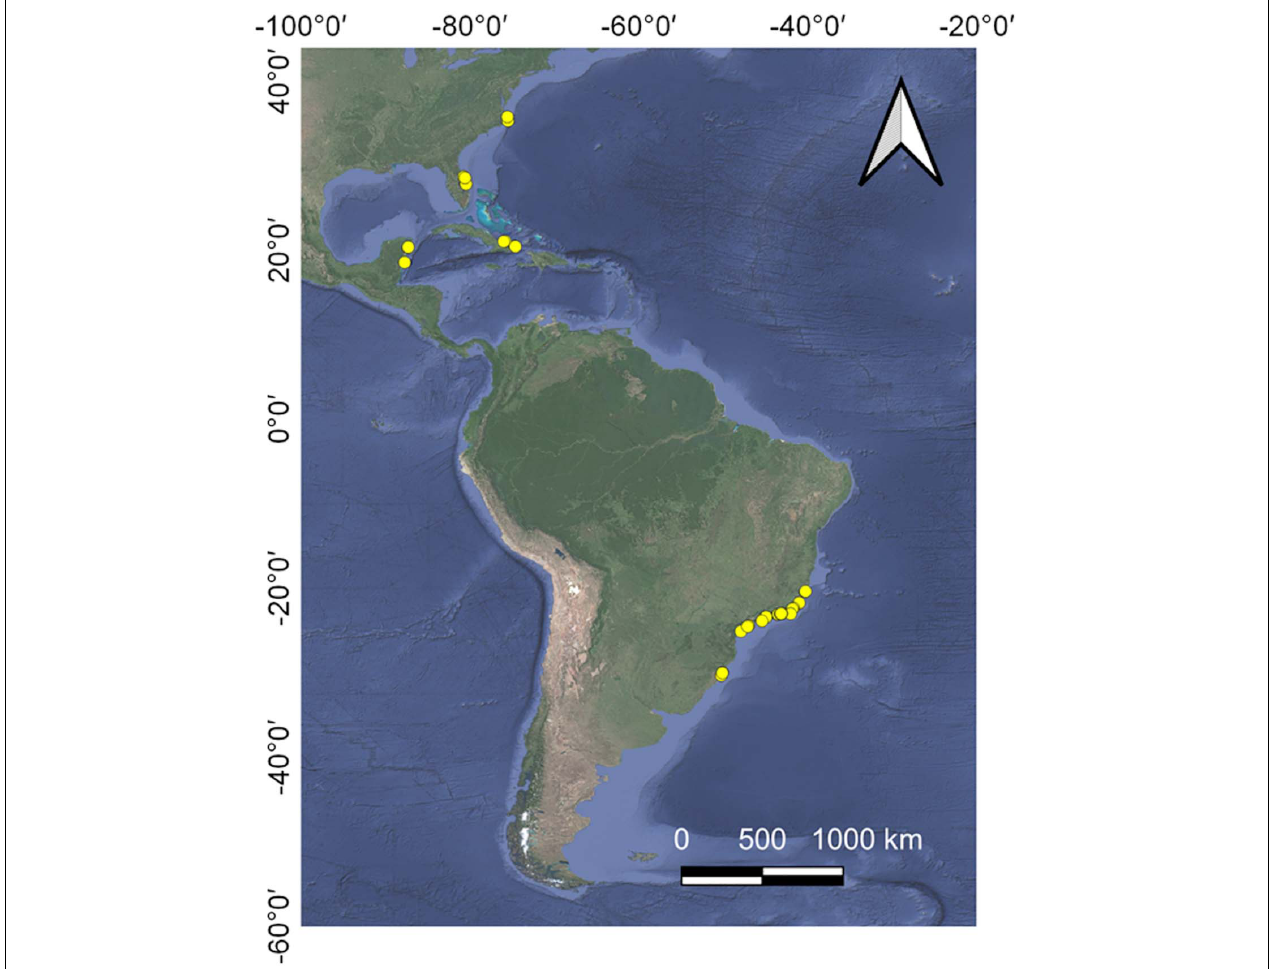
FIGURE 1 | Locations of the records of burrow density from 94 beach sectors in Western Atlantic